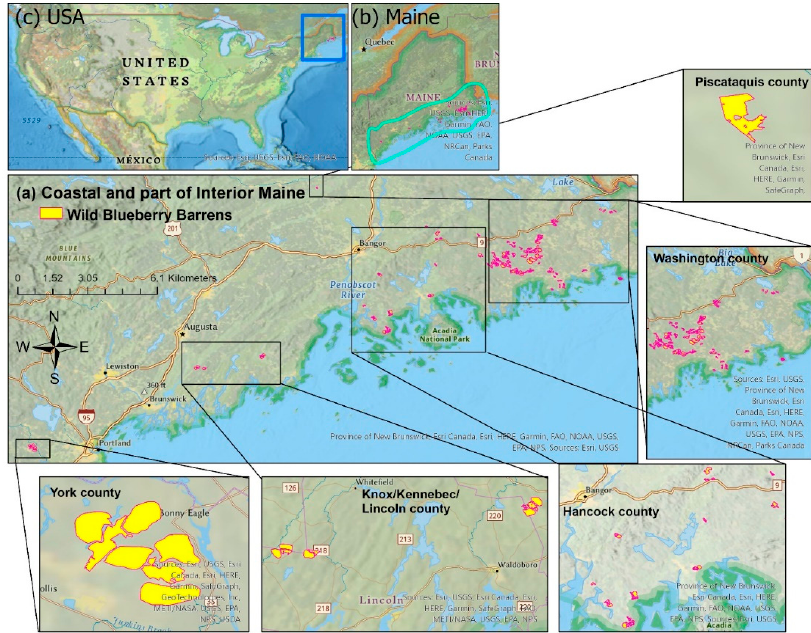
Figure 1. Locations of the studied wild blueberry barrens in different counties from north-central (Piscataquis) and north-east (Washington, Hancock) to south-west (Knox, Lincoln, Kennebec, York) at the ( a ) coastal and interior climate regions of ( b ) Maine at the north-east of ( c ) the United States of America. The yellow-colored polygons with pink-colored boundaries indicate the studied wild blueberry barrens (WBBs) (area of each barren ≥ 0.5 km 2 ). Different counties and climate regions of Maine are shown in Figure S1 in the supporting materials of this study.